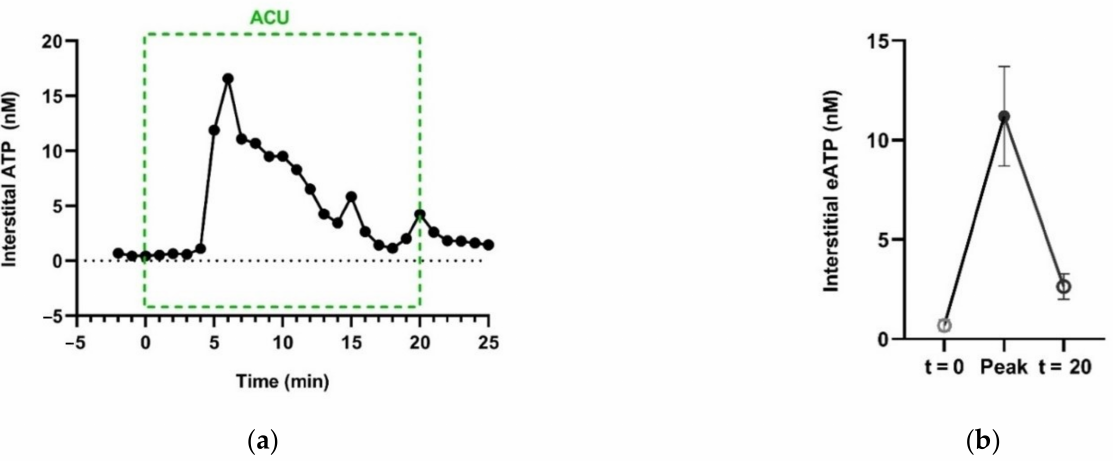
Figure 14. Acupuncture-induced transient accumulation of interstitial ATP in treated acupoints. ( a ), Representative trace of ATP concentration in response to needling manipulation, dominated by twirling-rotating (~100 times/min), supplemented with lifting-thrusting (~80 times/min). ATP in the interstitial space was collected with microdialysis method and assayed with luciferase-luciferin assay. ( b ) Comparison of [eATP] of baseline (t = 0), peak and termination of AP. See Figure 5 legend for the establishment of the inflammation pain and acupuncture intervention. The data represent averages + SEM ( n = 4) and are based on data from Zuo et al. (2022)